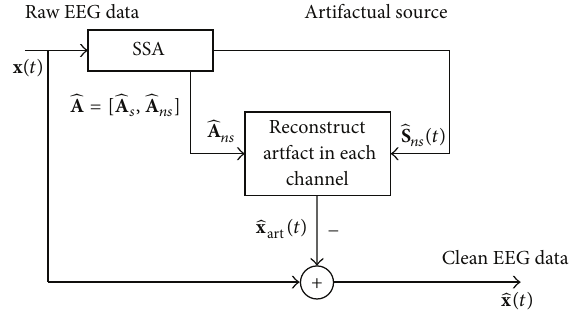
Figure 1: Block diagram of the proposed